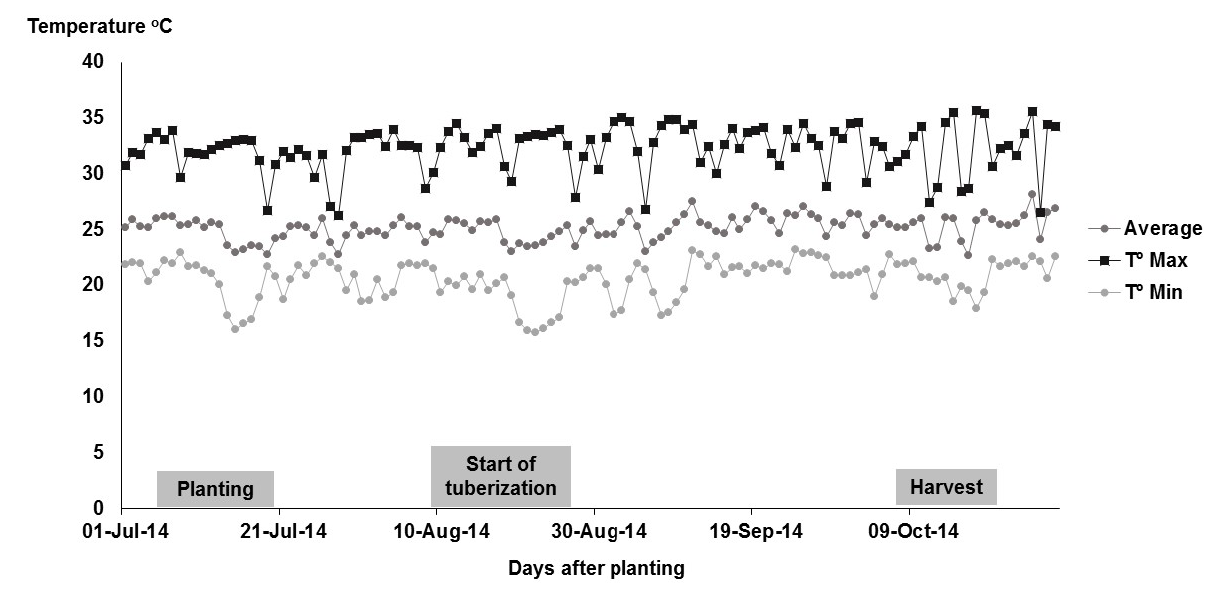
Figure 2: Temperatures during growing season in San Ramon, Peru